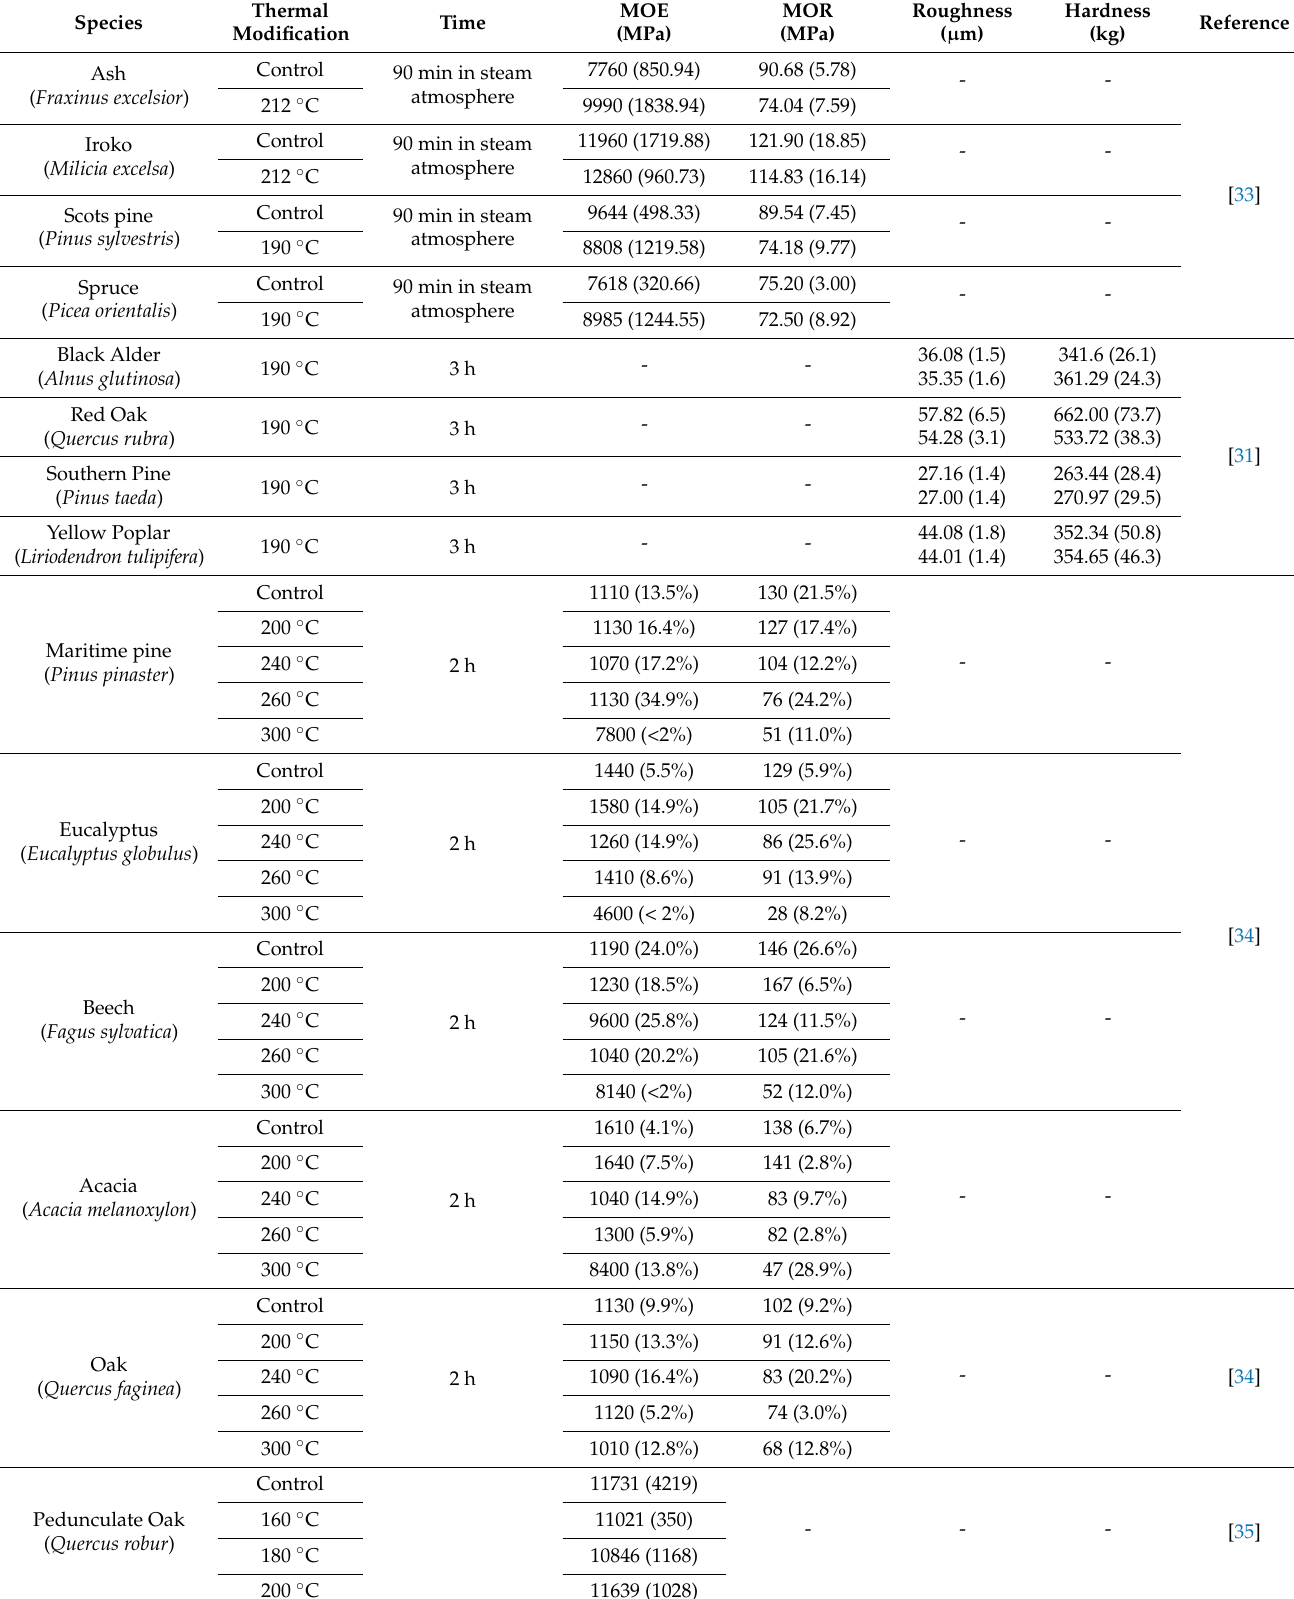
Table 3. Examples of the mechanical properties of some wood species before and after the thermal